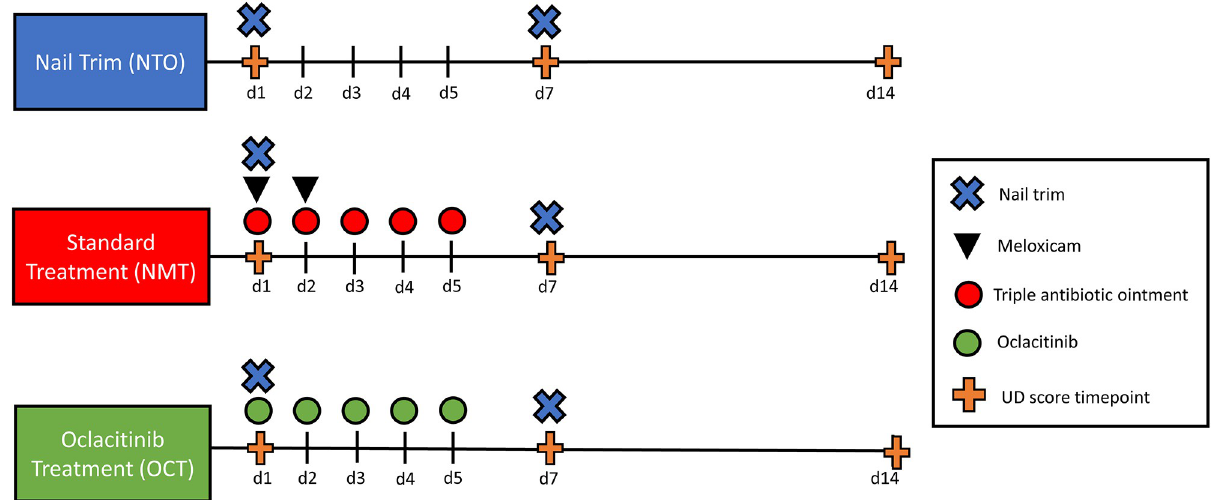
Fig 1. Treatment group and UD scoring timeline. Timeline for nail trims, medical treatments, and UD scoring for the 3 treatment groups: NTO (top), NMT (middle), and OCT (bottom).